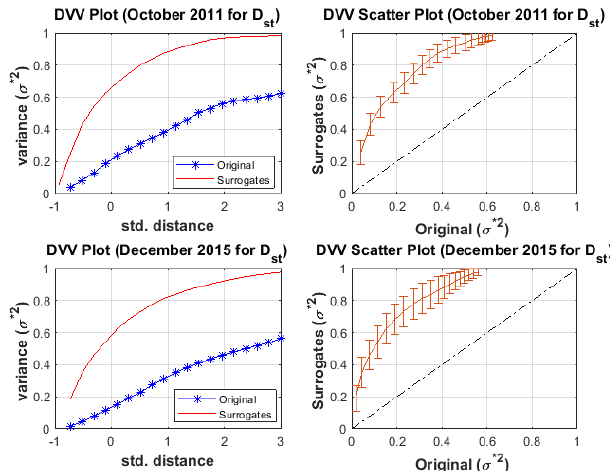
Figure 7. The DVV plot and scatter plot for D st during minor geo- magnetic storm for January 2009 and January 2014.